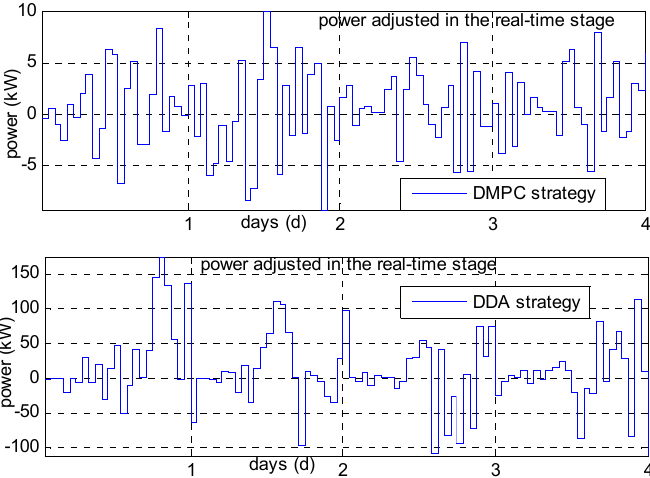
Figure 4. Power adjusted for DMPC and DDA strategies at real-time stage.